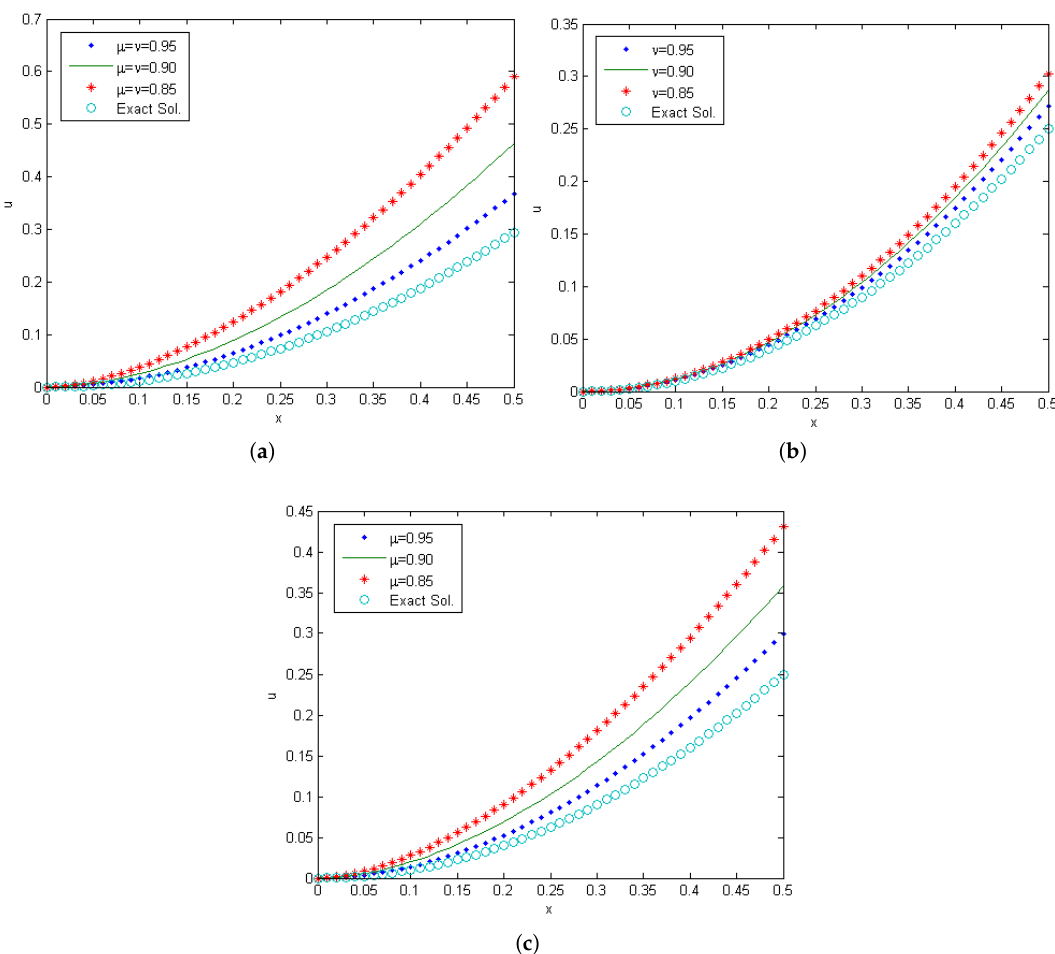
Figure 4. The solutions u ( x , t ) for Equation (40) for different values of µ and ν when t = 1. ( a ) Plot solutions u ( x , t ) for Equation (40) at µ = ν . ( b ) Plot solutions u ( x , t ) for Equation (40) when µ = 0.99 and different values of ν . ( c ) Plot solutions u ( x , t ) for Equation (40) for different values of µ at ν =